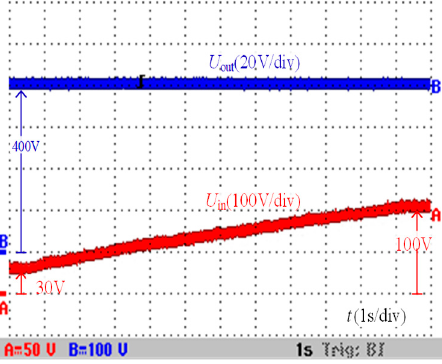
Figure 10. The output voltage and the wide-range input voltage from 30 V to 100 V.